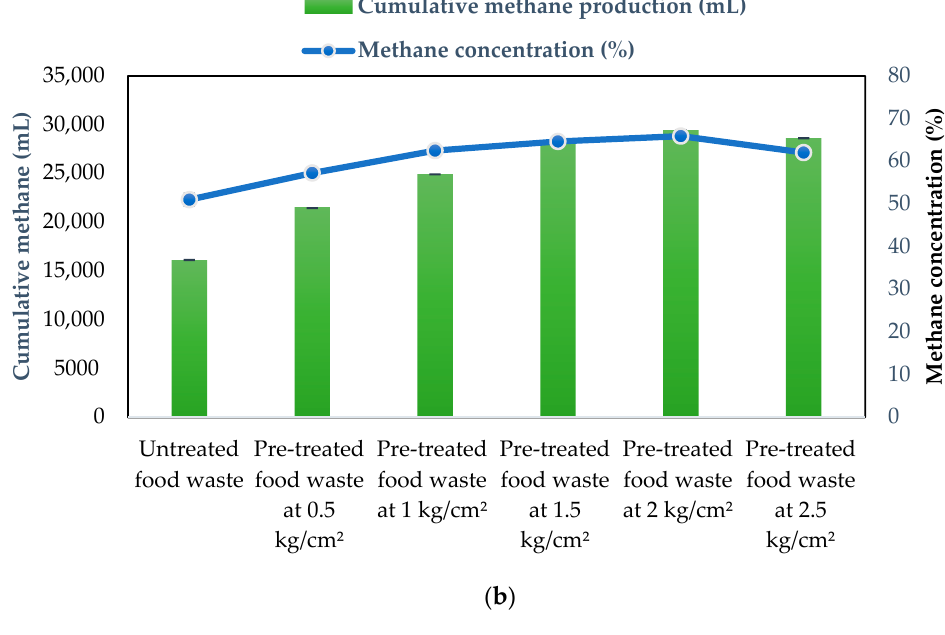
Figure 2. Effect of pressure pretreatment on cumulative biogas profile and methane profile with respect to methane concentration. ( a ) Cumulative biogas generation with pretreated food waste; ( b ) methane concentration profile for pretreated food waste at different pressures.